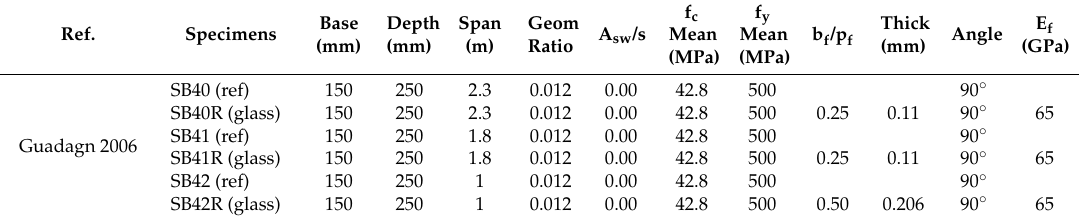
Table A2. Geometrical and mechanical properties of the selected RC beams and FRP strengthening: the “ref” beams are the ones without FRP retrofitting; glass and cfrp the FRP material types [38,39,54,72–77].